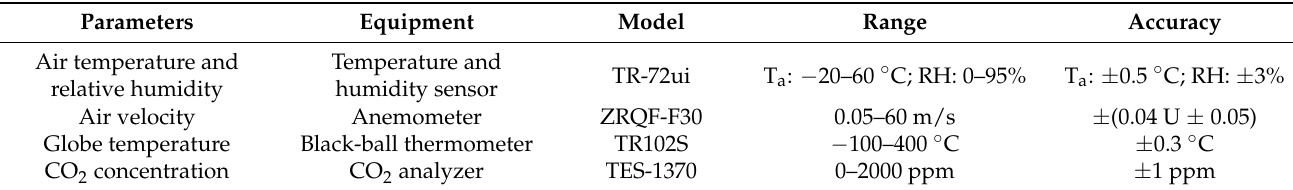
Figure 3. The classroom layout with sensor locations marked. Table 1. Information of the measuring equipment and parameters.